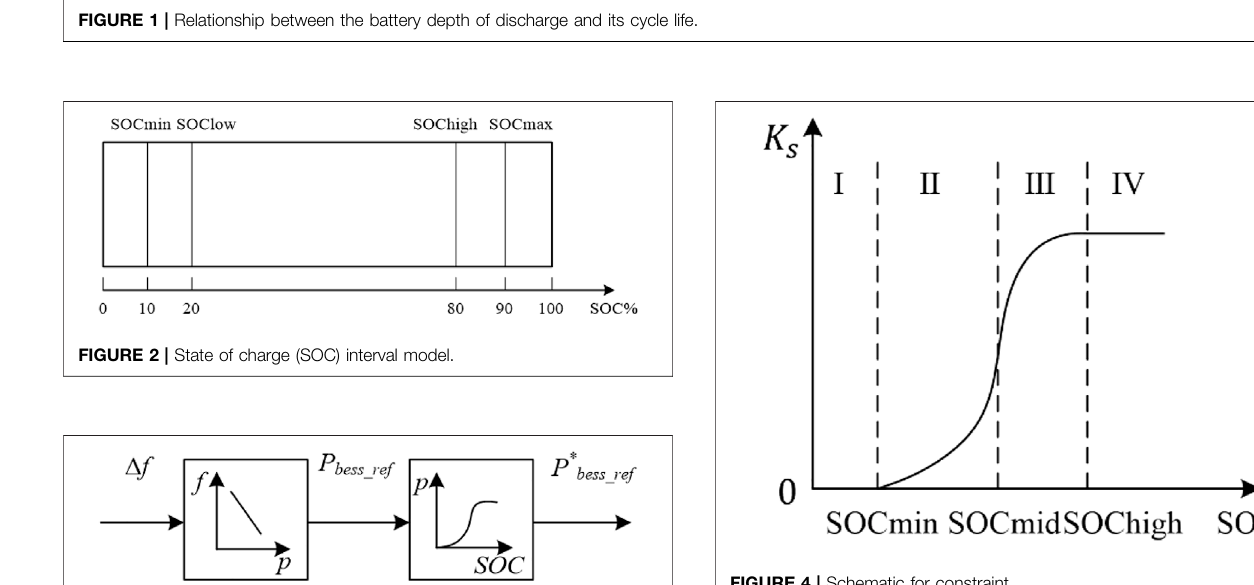
FIGURE 4 | Schematic for